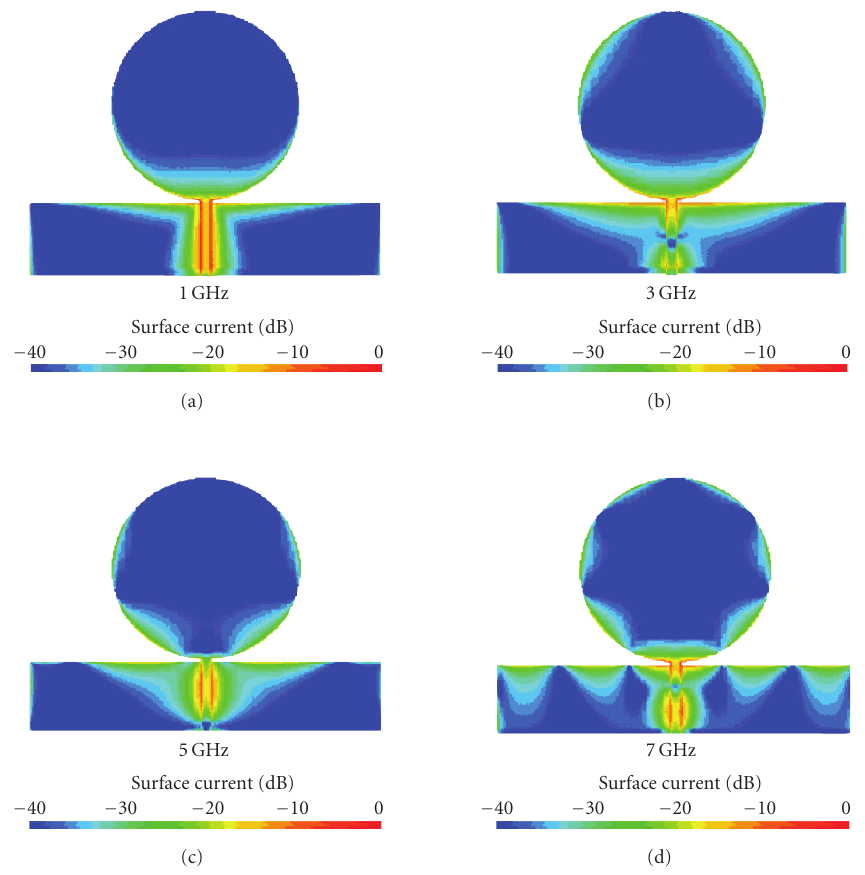
Figure 6: Simulated current distributions of a PEMA at 1GHz, 3 GHz, 5GHz, and 7GHz.